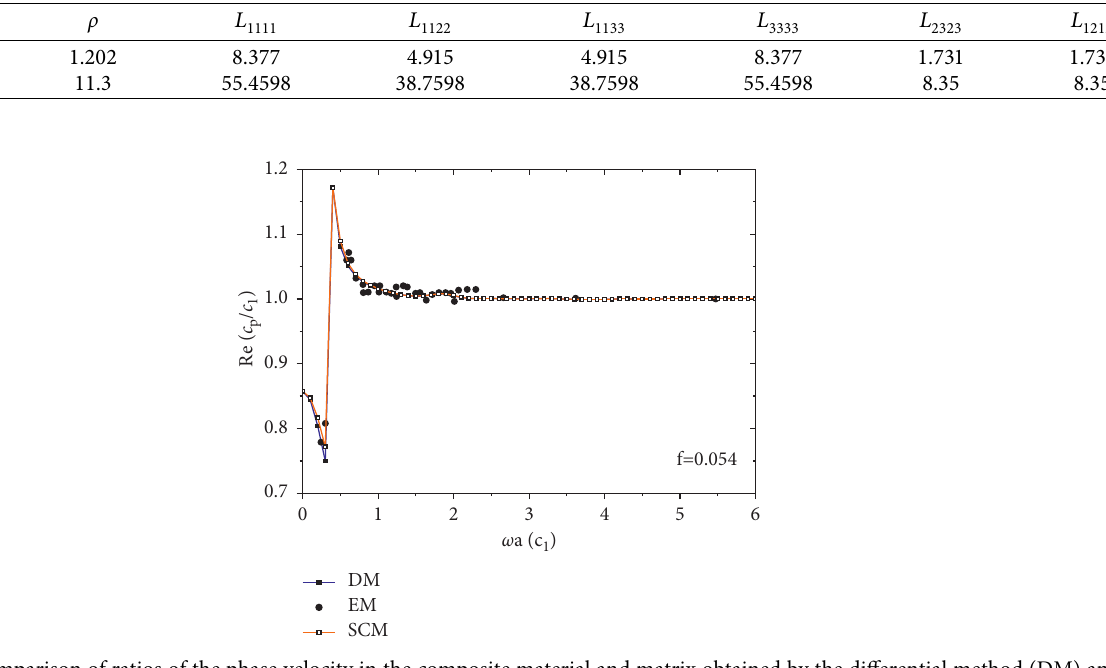
Figure 2: Comparison of ratios of the phase velocity in the composite material and matrix obtained by the differential method (DM) and self-consistent method (SCM), and experimental results (ER) in the case of quasi-P wave propagates in the composite material for inclusion volume fraction of 5.4% and δ � 1.